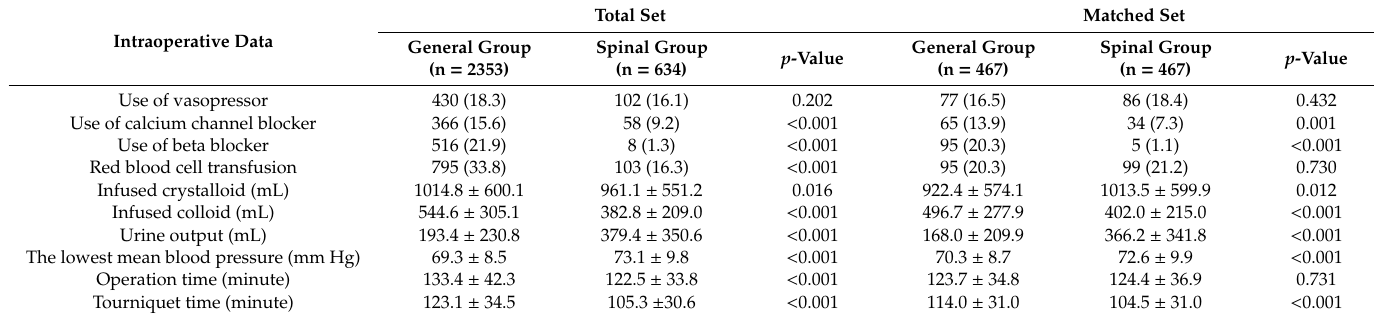
Table 3. Intraoperative data of the study groups by anesthetic technique in total and matched sets.